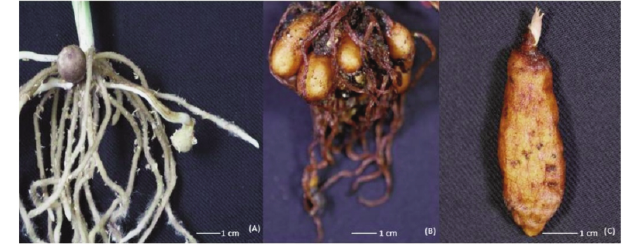
Fig. 7 ­ Tubers of the parents and hybrids. (A) HRA, (B) WXO2, (C) RC.